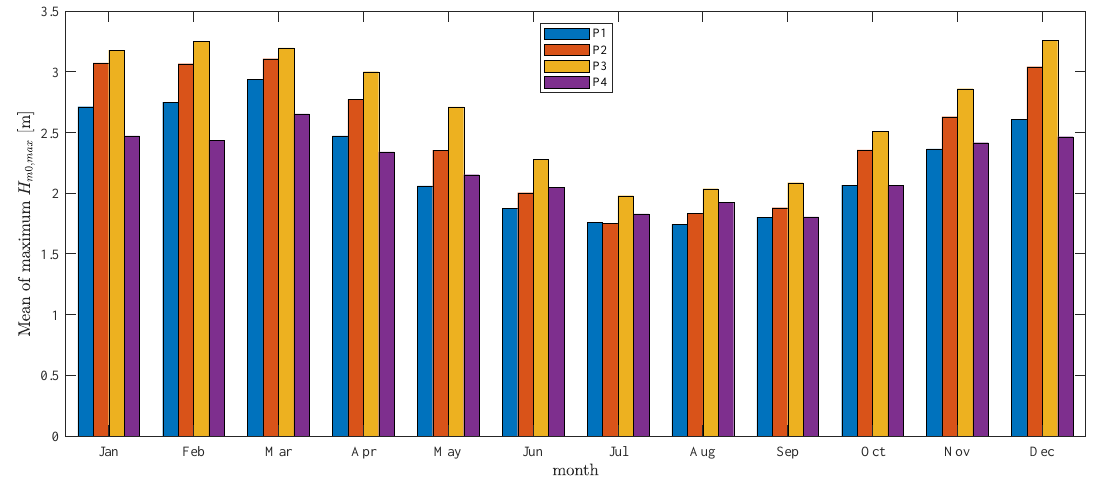
Figure 4. Average values of monthly maximum spectral significant wave heights H m 0, max